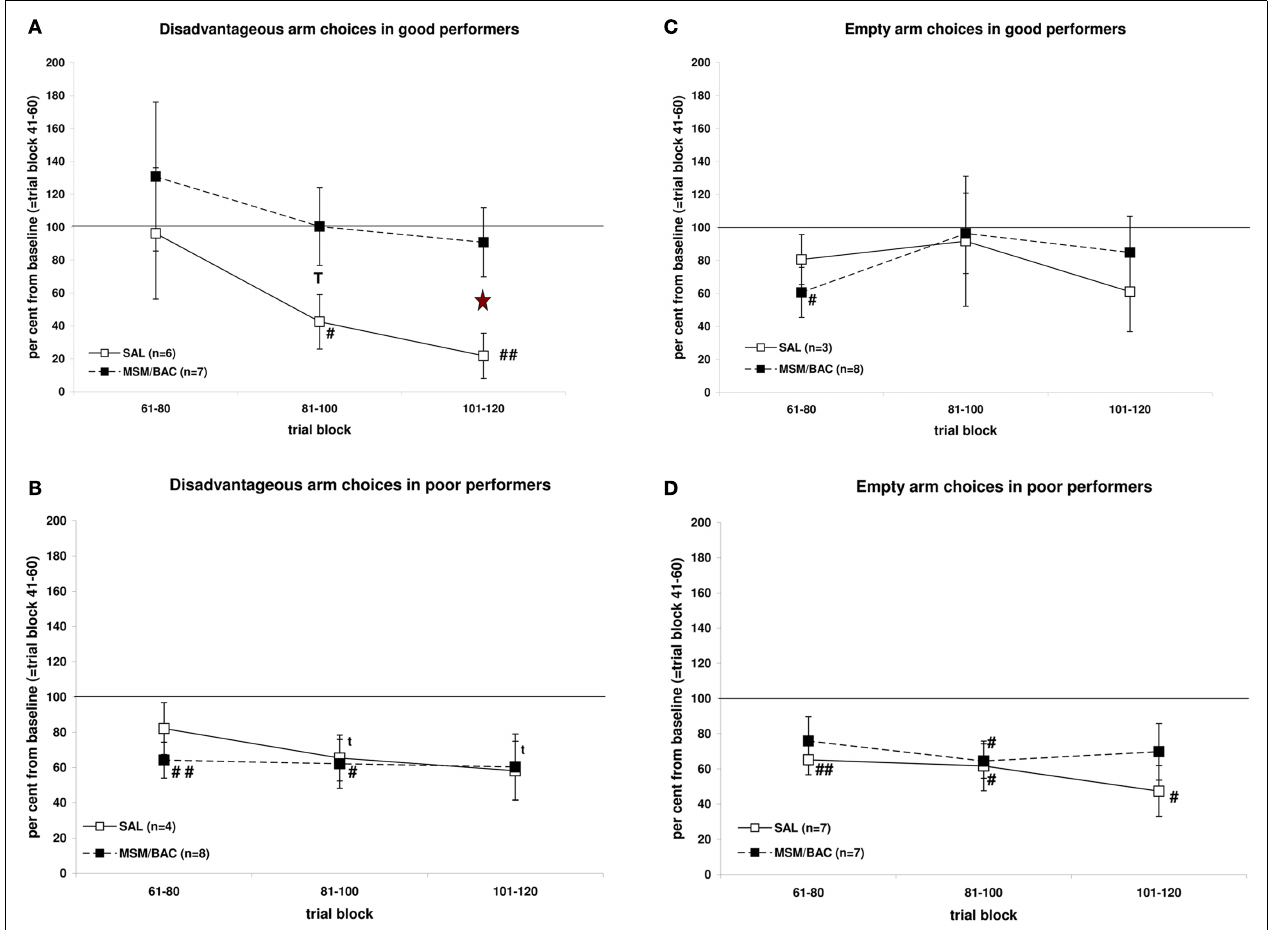
( = trial block 41–60). T : p ≤ 0.10 MSM/BAC versus saline; *: p ≤ 0.05 MSM/BAC versus saline; t : p ≤ 0.10 relative to 100%; #: p ≤ 0.05 relative to 100%; ##: p ≤ 0.01 relative to 100%.